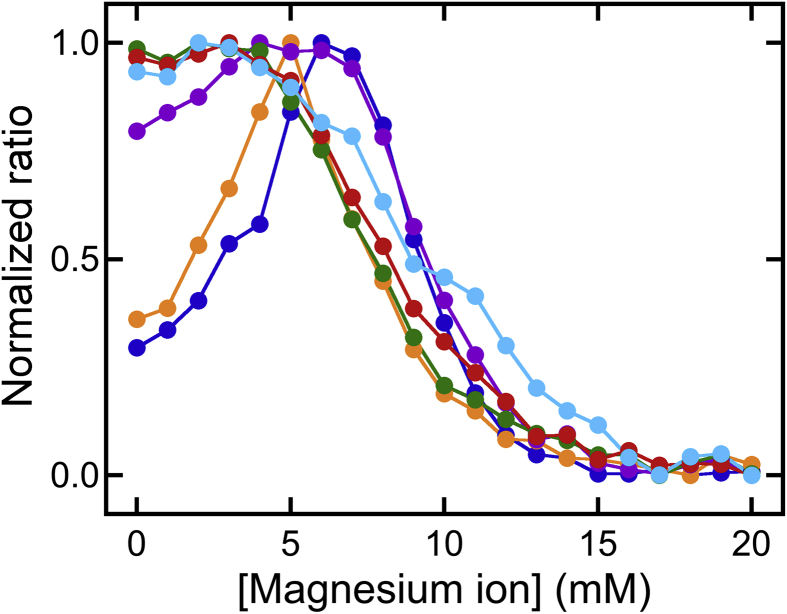
Comparison of the urea-soluble protein concentrations at different Cl− concentrations. (A) The normalized ratio was calculated from the concentration of urea-soluble proteins shown in Fig. 3 using Eq. (1). The ratio was plotted against the Mg2+ concentration in the presence of Cl−. The Cl− concentration was 40 (blue circles and line), 60 (orange circles and line), 80 (purple circles and line), 100 (green circles and line), 120 (red circles and line), or 140 mM (cyan circles and line).